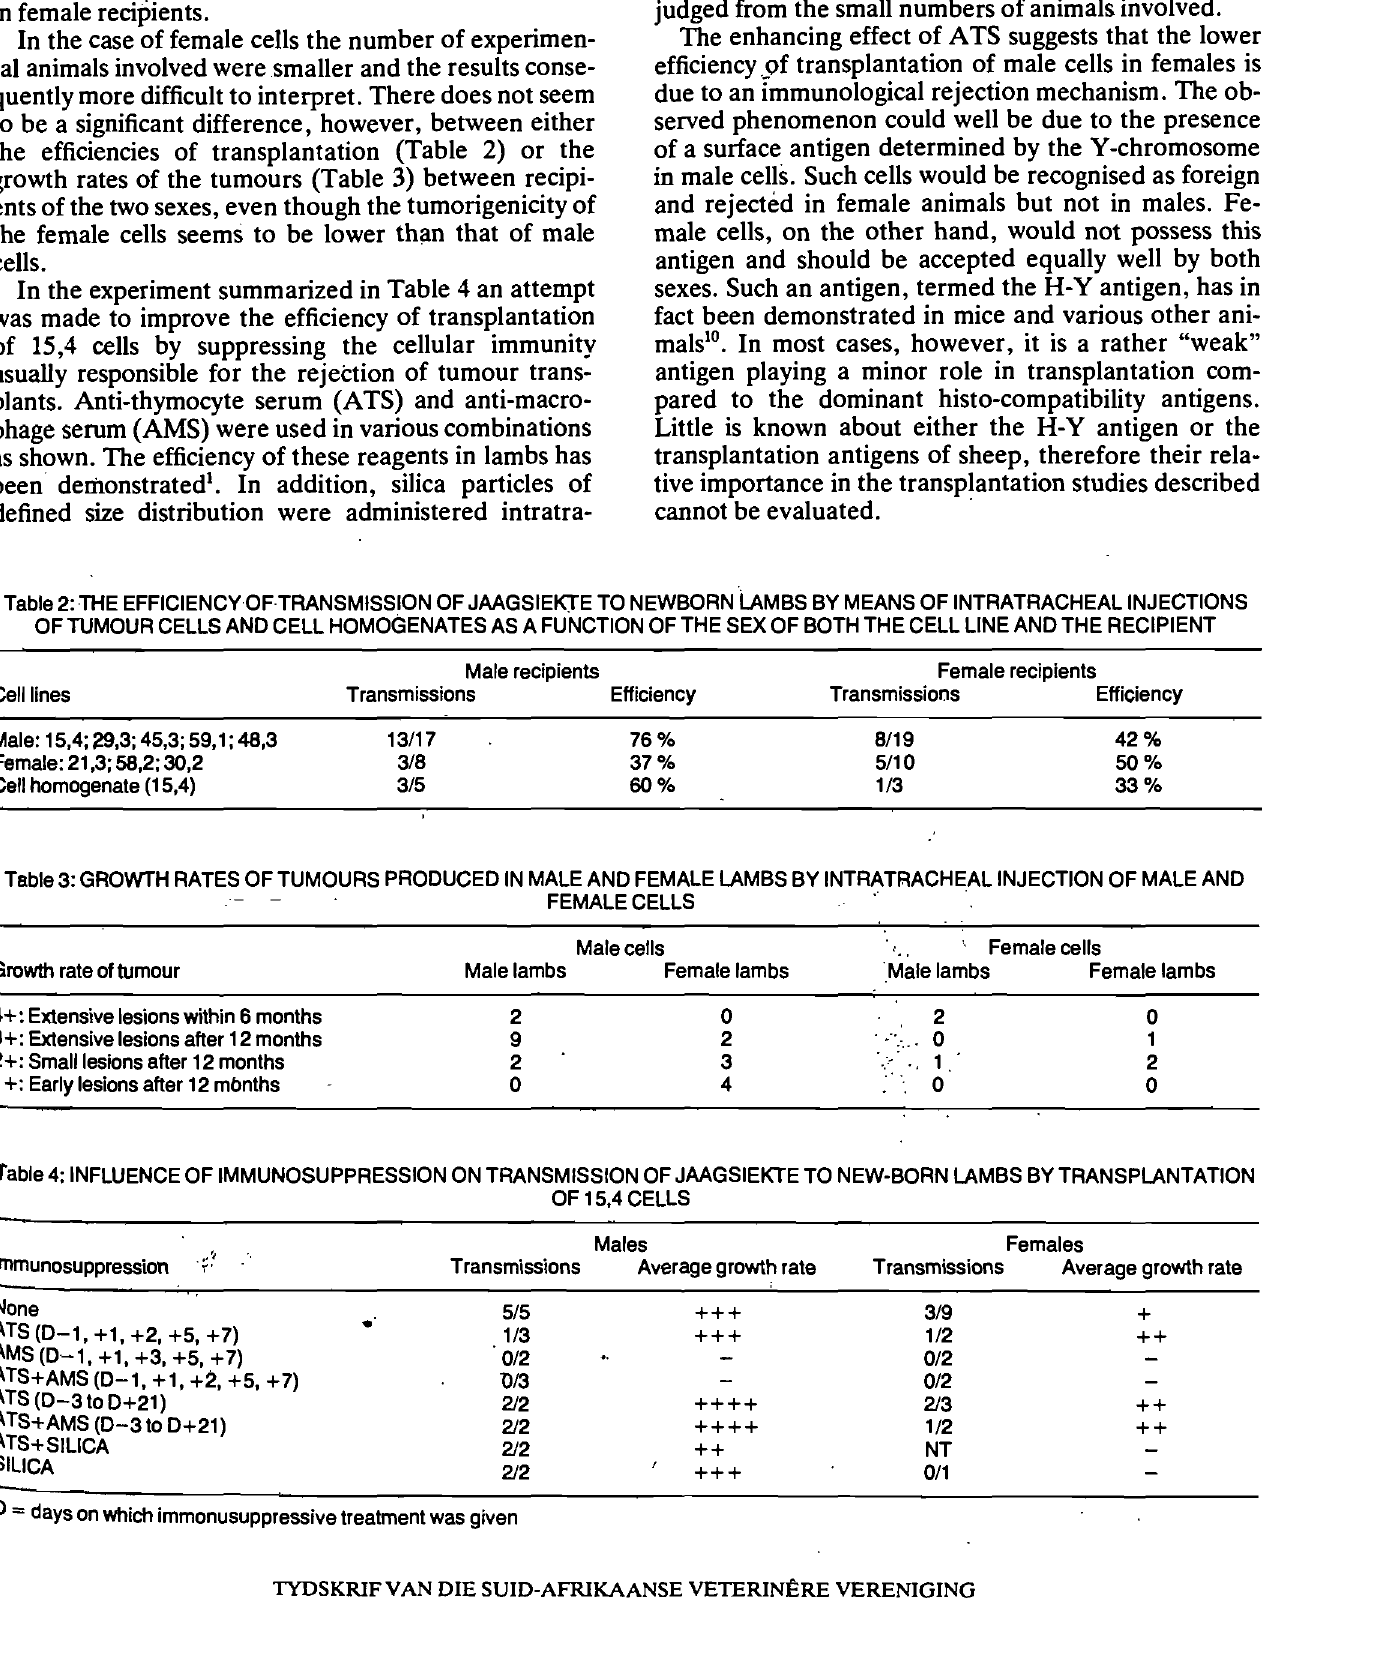
Table 4: INFLUENCE OF IMMUNOSUPPRESSION ON TRANSMISSION OF JAAGSIEKTE TO NEW-BORN LAMBS BY TRANSPLANTATION OF 15,4 CELLS ... Immunosuppression